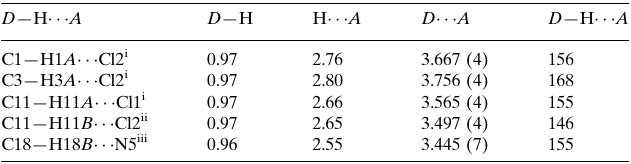
Hydrogen-bond geometry (A˚ , (cid:3)